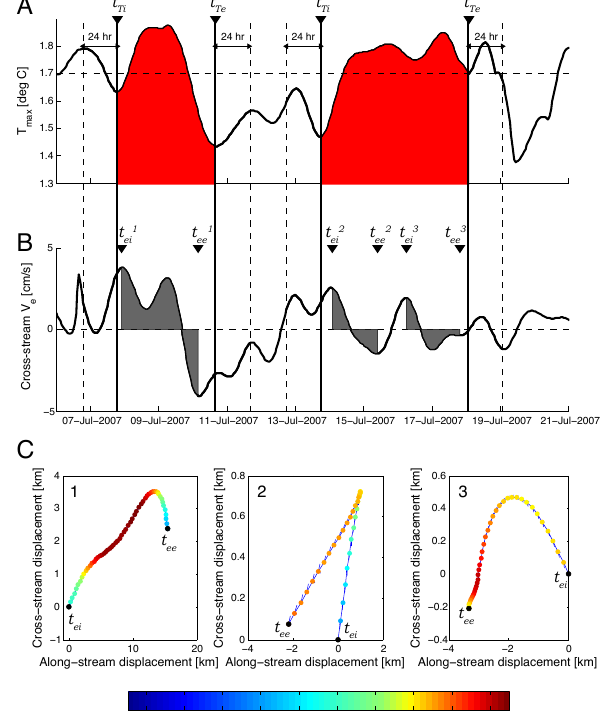
Fig. 7. Example of detection scheme for two detected T max peaks — not the cleanest examples in the records, but rather a case of one eddy followed by the much more rare case of two eddies. (A) Time series of T max , showing the search windows 1t T = ( t T i – 24h, t T e + 24h) for two detected peaks in T max . (B) The cross-stream eddy velocity over the same time intervals with the chosen bounds for the ith eddy, denoted by 1t i v = ( t i , t i ee ), within corresponding ei 1t T . (C) Progressive vector diagrams for the eddy velocity of the three eddies found in (B) , summed over 1t i v and color coded by T max